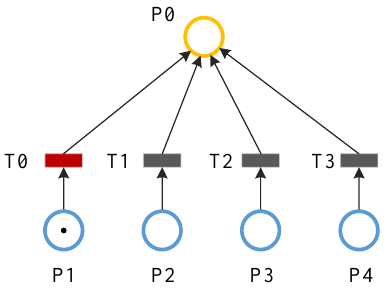
Figure 9. Assign the initial value to Place L2.